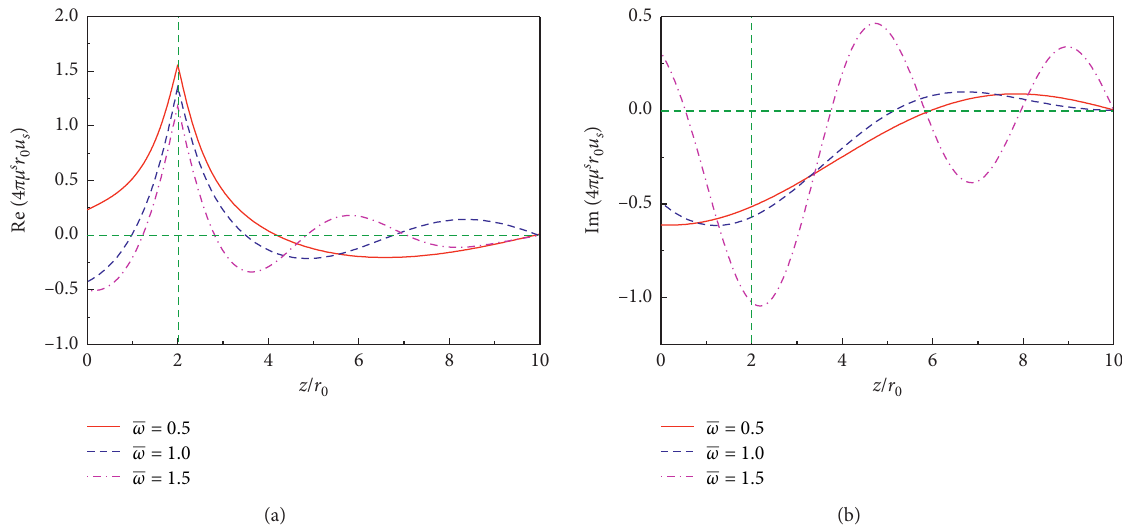
Figure 6: Lateral displacement u